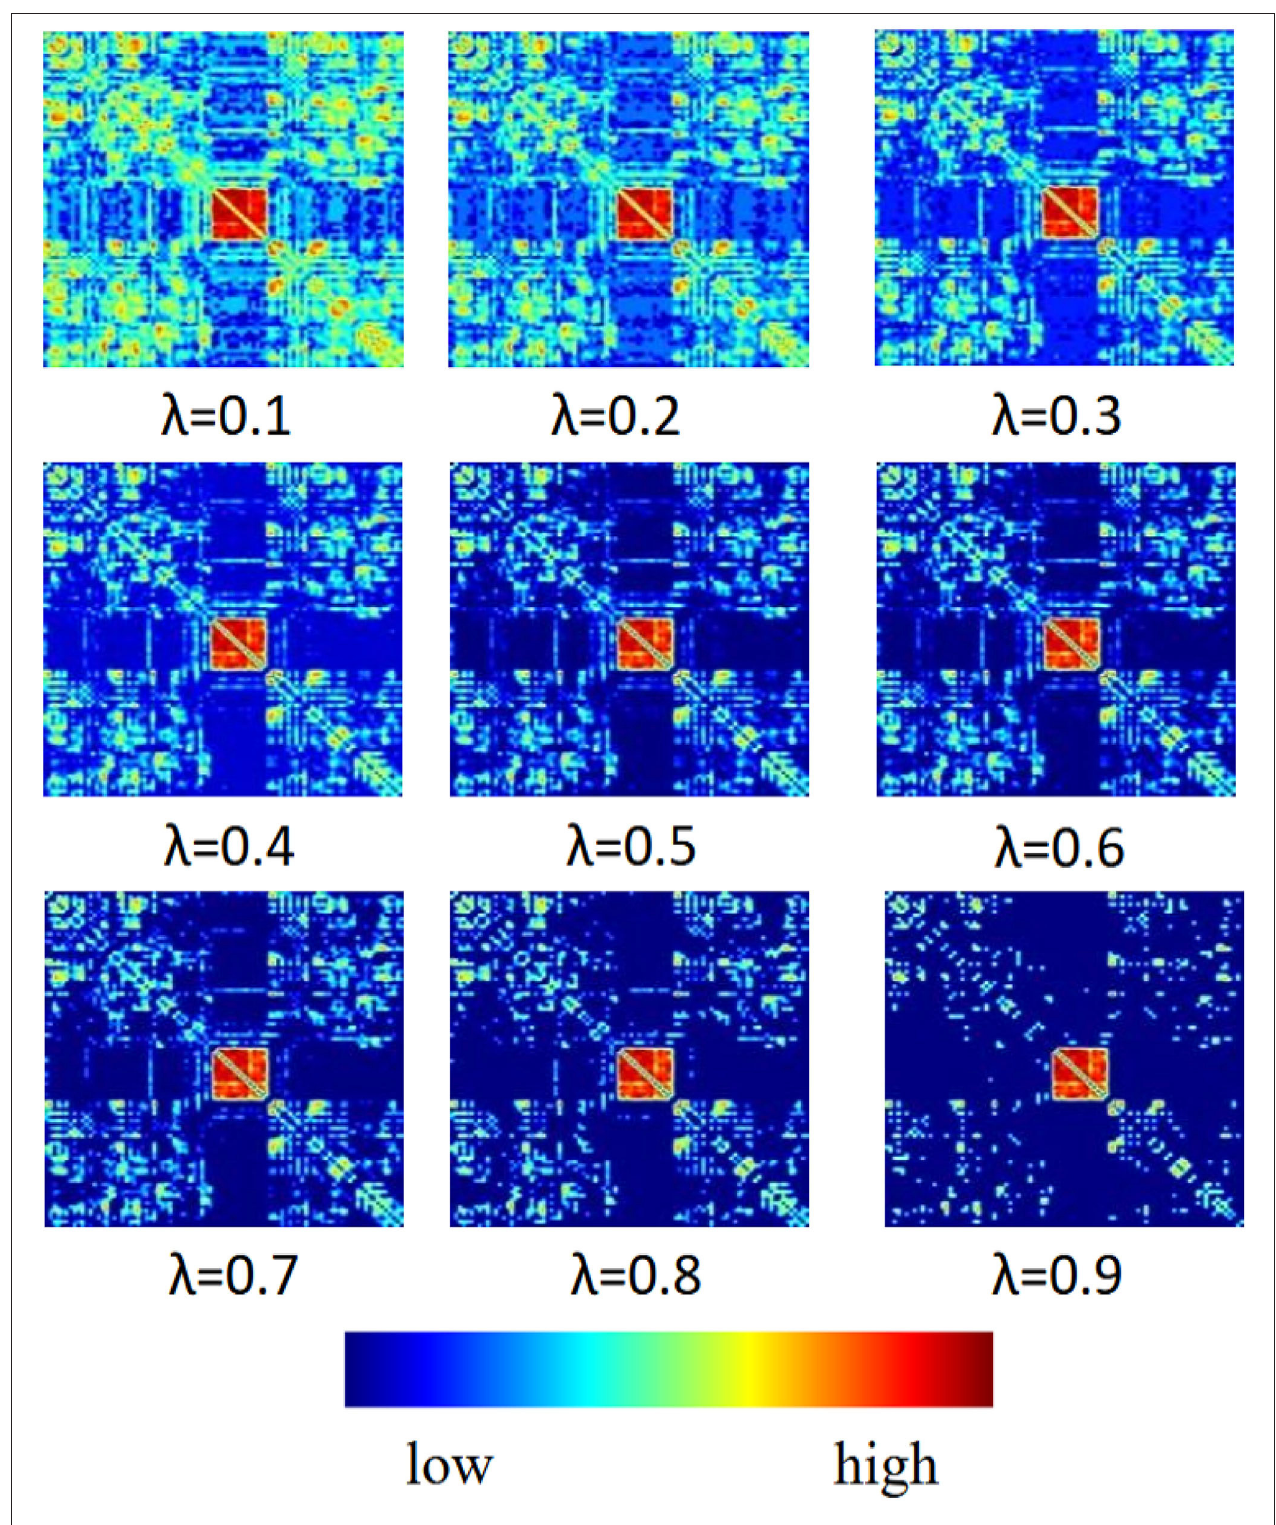
FIGURE 4 | Visual illustration of brain node